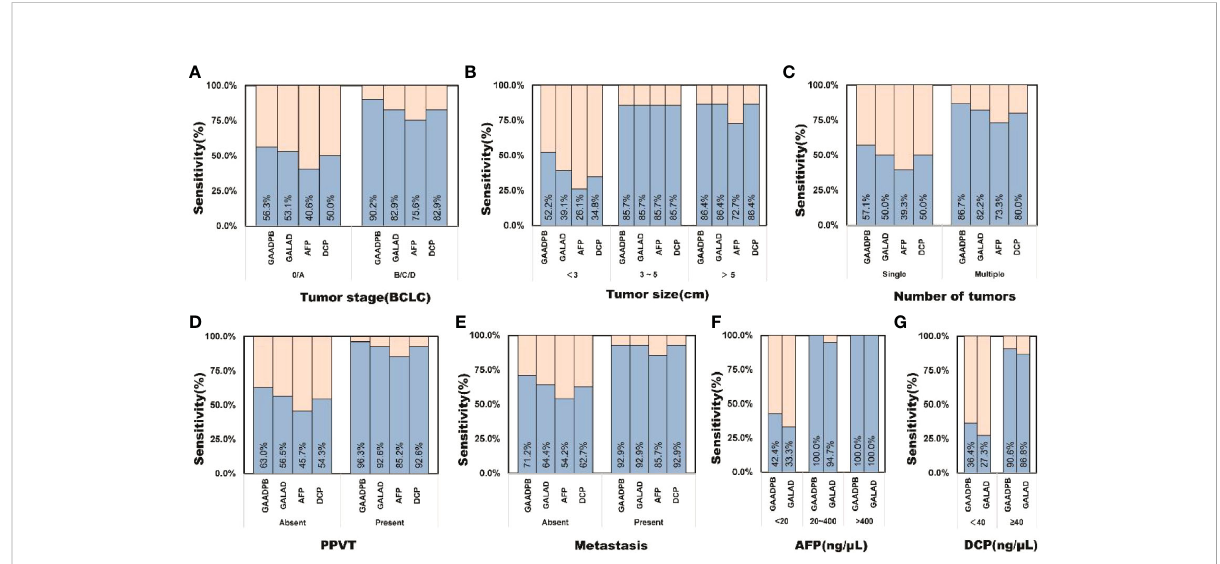
FIGURE 5 The sensitivity of GAADPB in different cancer subgroups of test set. (A) , Tumor stage (BCLC) (B) , Tumor size (C) , Number of tumors (D) , PPVT (E) , Metastasis (F) , AFP (G) , DCP. HCC, hepatocellular carcinoma; LC, liver cirrhosis; CHB, chronic hepatitis B; HC, healthy controls, PPVT, portal vein tumor